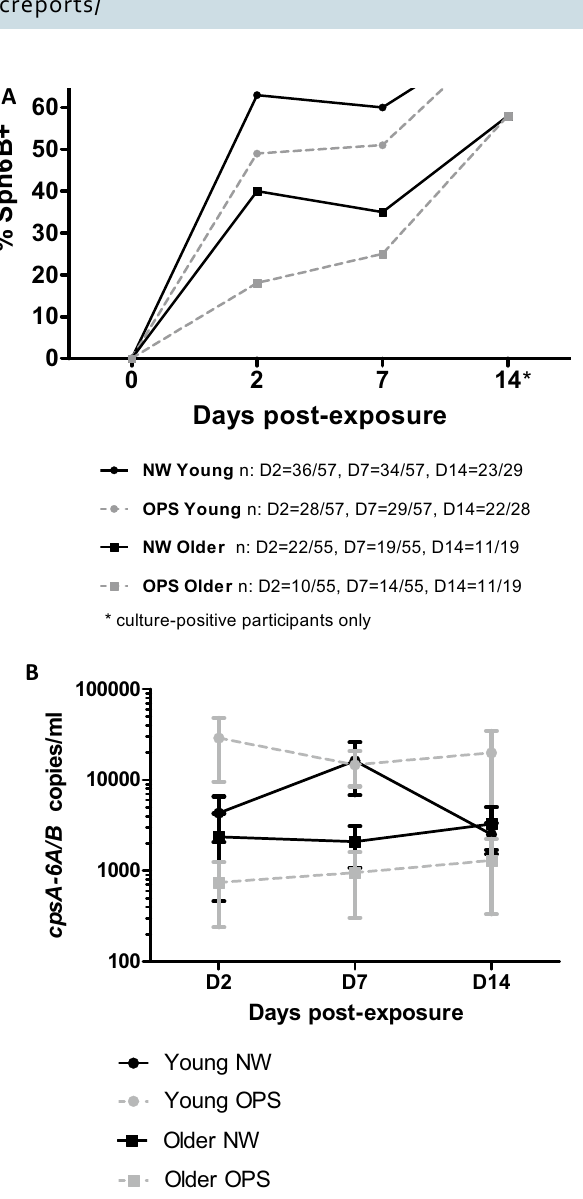
Figure 1. Experimental pneumococcal colonization in young (18–55 years, n = 57) and older adults (> 55 years, n = 55). ( A ) Frequency of Spn6B pneumococcus in nose (NW) and oropharynx (OPS) in both age groups. Detection of pneumococcal DNA was determined by multiplex qPCR. Participants with qPCR results positive for Spn6B (CT < 40) in the nose and oropharynx per day post-exposure per age group were: Young NW: D2 n = 36/57, D7 n = 34/57, D14 n = 23/29, Young OPS: D2 n = 28/57, D7 n = 29/57, D14 n = 22/28, Older NW: D2 n = 22/55, D7 n = 19/55, D14 n = 11/19, Older OPS: D2 n = 10/55, D7 n = 14/55, D14 n = 11/19. The number of volunteers with Spn6B + sample (CT < 40) in each day post-exposure is expressed as a percentage (%) of the total number of volunteers. Statistical significance was assessed by Fisher’s contingency test: Young vs Older adults: NW D2 P = 0.014, D7 P = 0.008, D14 P = 0.1931 and OPS D2 P = 0.0007, D7 P = 0.007, D14 P = 0.1946, Older adults NW vs OPS: D2 *P = 0.020. ( B ) Density of Spn6B pneumococcus in nose (NW) and oropharynx (OPS) in both age groups. Each time point represents the average density of SPN6B + per study day per niche. Data was log transformed. Graphs were created in GraphPad Prism version 5.0 for Windows, GraphPad Software, USA, www. graph pad.